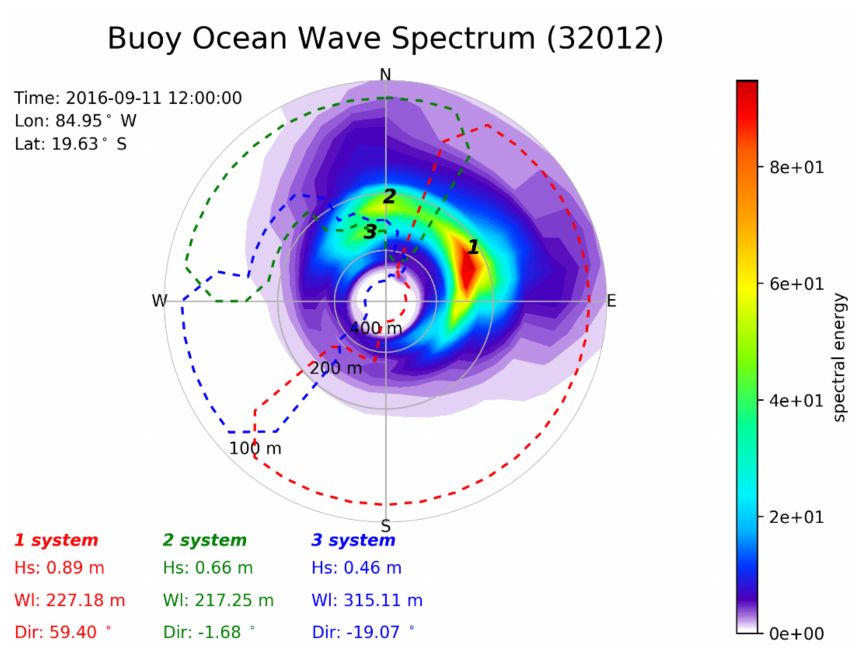
Figure 7. Buoy ocean wave spectrum from NDBC station 32012 (19.63 ◦ S/84.95 ◦ W) on 12:00:00 UTC 11 September 2016.